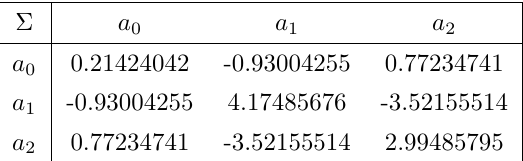
Table 6. Covariance matrix for the parameters of the supergravity (cid:12)t with string corrections in eq.